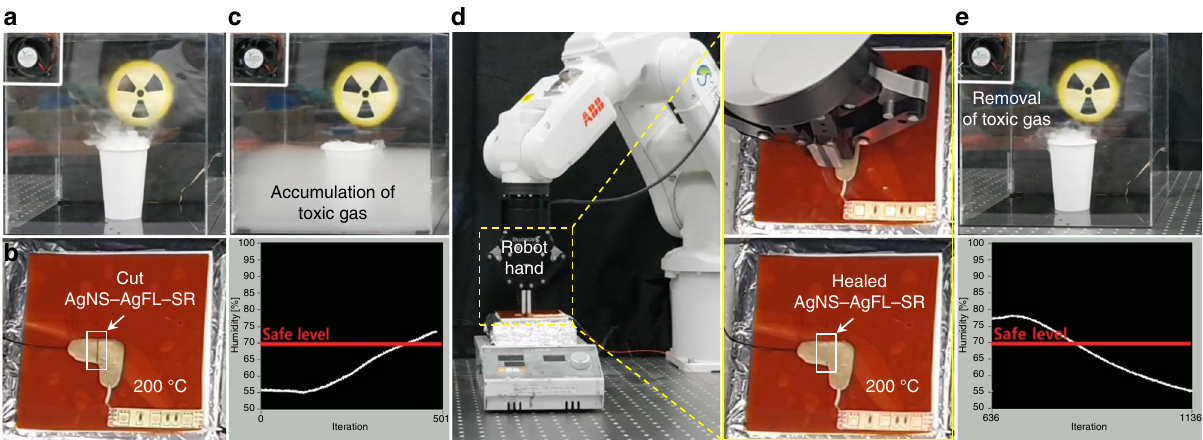
Fig. 7 The robot application demonstration of the AgNS-AgFL-SR nanocomposite. a An exhaust fan was connected to the healable AgNS-AgFL-SR (Ag = 44 vol%, THF peroxide = 15 mL) nanocomposite circuit at 200 °C, removing toxic gas at harsh conditions. b, c The circuit was cut, accumulating the toxic gas and increasing the gas concentration (relative humidity) above the safe level. d The robot healed the AgNS-AgFL-SR circuit. The healed circuit image is provided in the inset. e The fan restarted, removing the toxic gas and decreasing the gas concentration below the